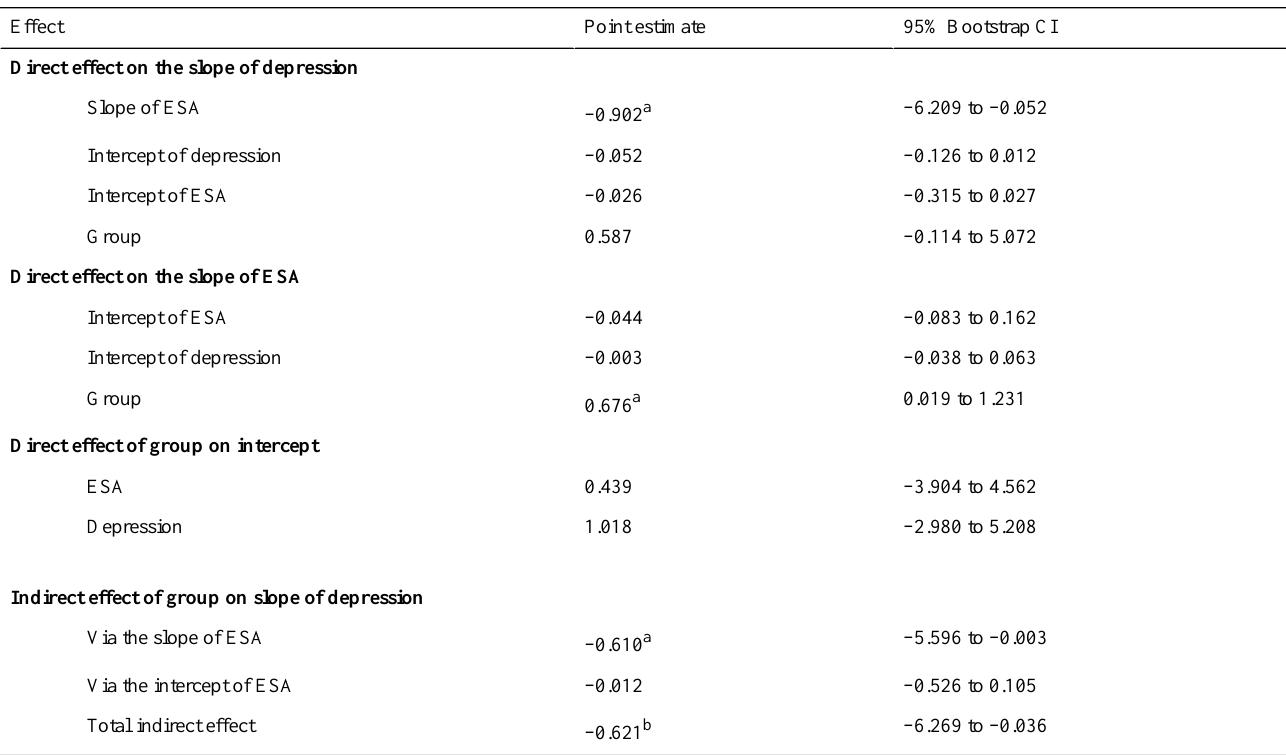
Table 4. Coefficients and bias-corrected bootstrapping confidence intervals (CIs) of the parallel process latent growth curve